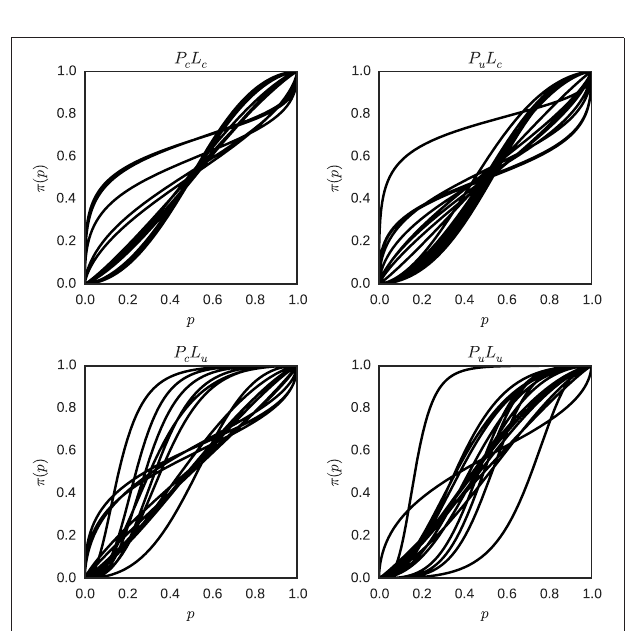
FIGURE 9 | Individual probability weighting functions using the posterior mean for γ and p 0 with unrestricted inter-individual differences for the different conditions ( P c L c , P u L c , P c L u , and P u L u ). Each plot represents one condition, and each line represents the best estimate obtained for the weighted probability function for one individual in that condition.